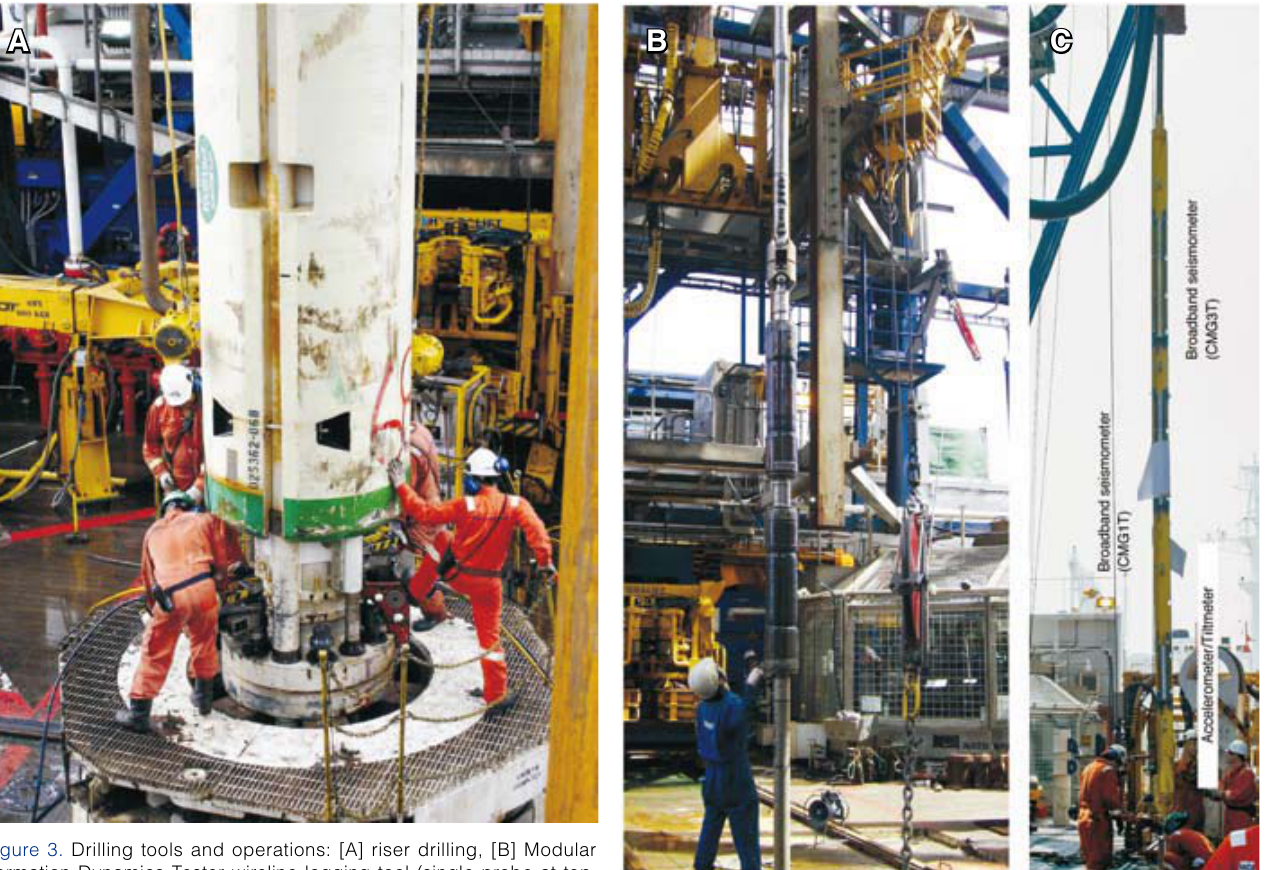
Figure 3. Drilling tools and operations: [A] riser drilling, [B] Modular Formation Dynamics Tester wireline logging tool (single probe at top, dual packer below), [C] observatory dummy run